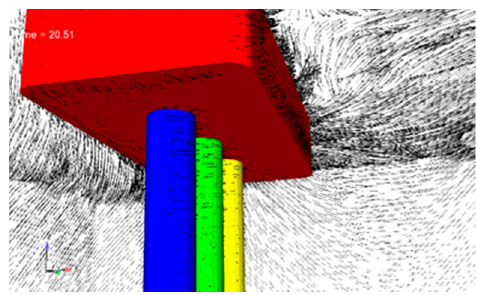
Figure 7. Variations of the flow velocity around the connection part between the cap and pile.